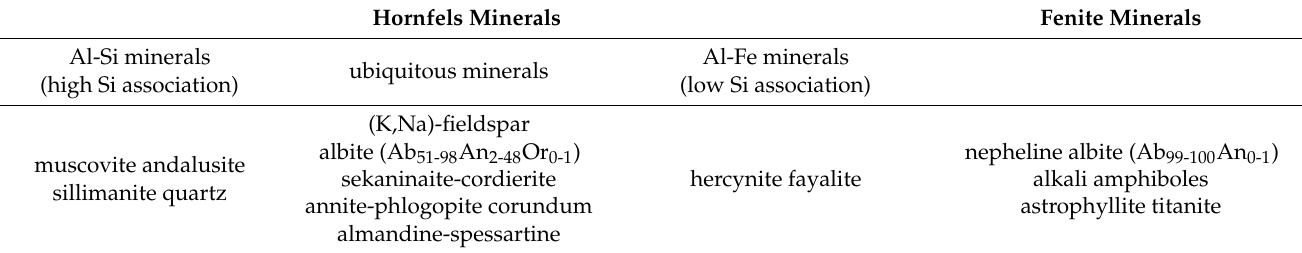
Table 3. Groups of rock-forming minerals of aluminous